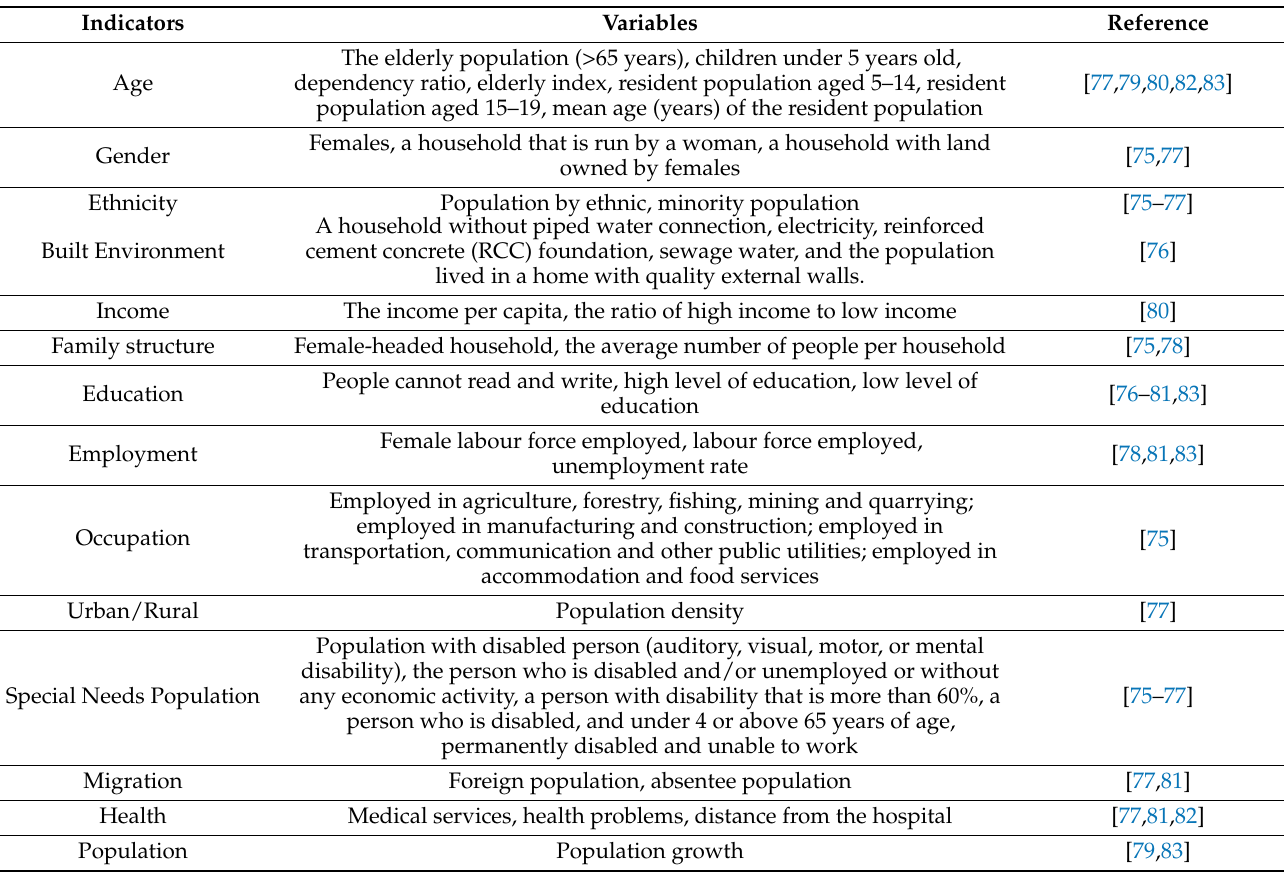
Table 6. List of indicators use as social vulnerability